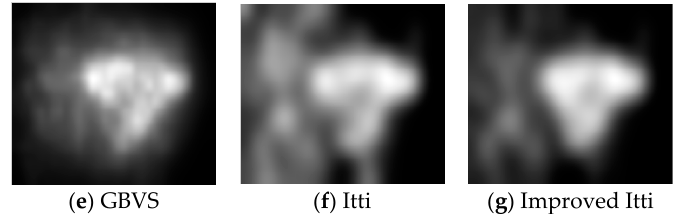
Figure 8. Comparison of different visual saliency models. ( a ) Original image; ( b – d ) salient overlap maps of GBVS model, Itti model and improved Itti model respectively; ( e – g ) salient maps of GBVS model, Itti model and improved Itti model respectively.